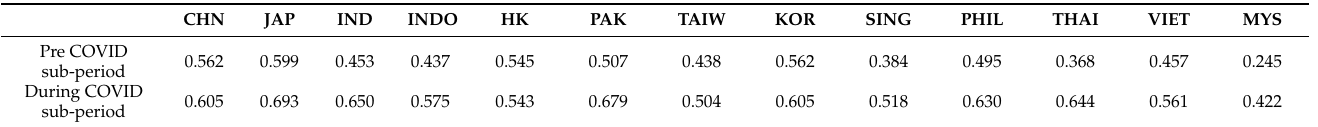
Table 5. Average values of hedging effectiveness.